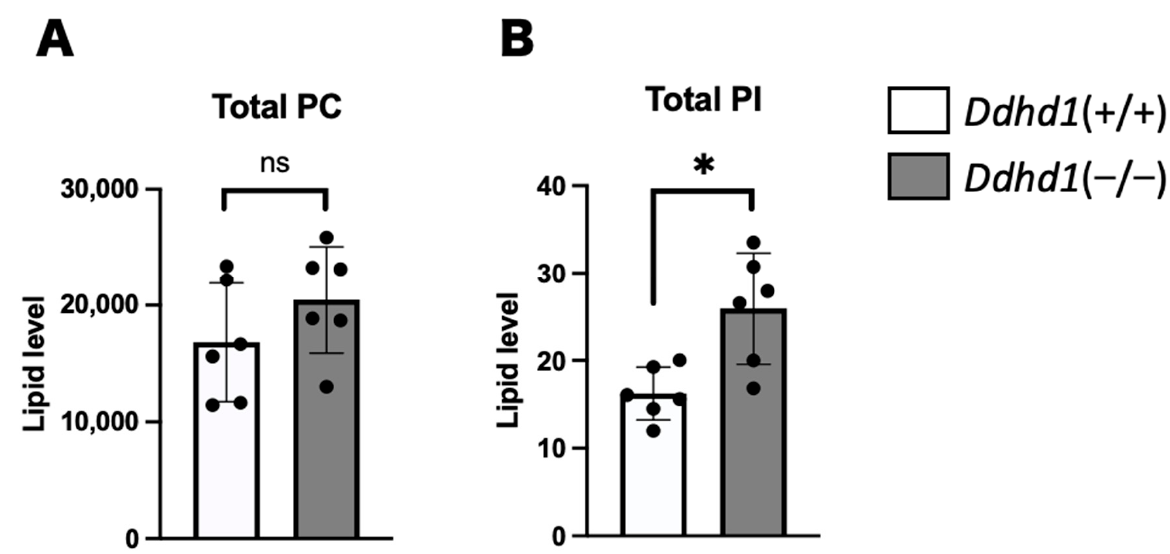
Figure 2. Comparison of total amount of PC and PI. Total amount of PC ( A ) and PI ( B ) in plasma from mice (n = 6 each). Ddhd1 (+/+) mice and Ddhd1 ( − / − ) mice are shown in opened and filled columns, respectively. The unit of the vertical axis is pmol/mg. Error bars indicate mean ± SD. ns: not significant, *: p < 0.05. All data were analyzed by Student’s t